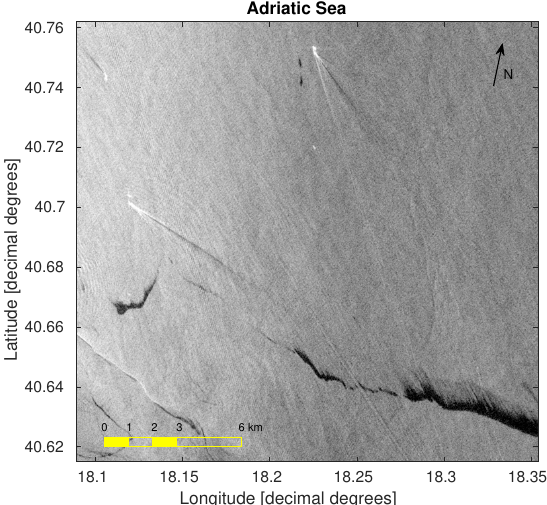
Figure 4. CSK StripMap HIMAGE of the southern Adriatic Sea after morphological processing (image not rotated into the Lat-Lon